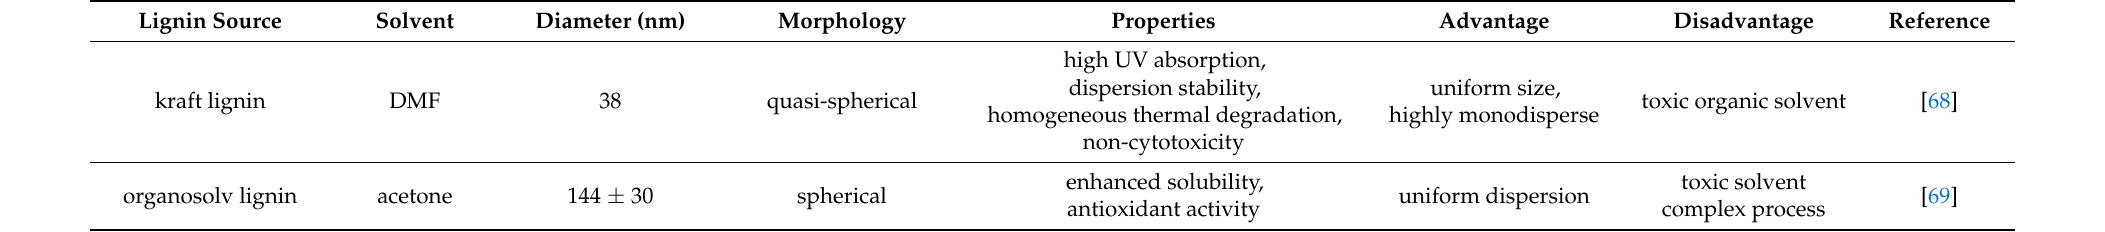
Table 3. Preparation of Lignin Nanoparticles by Using Supercritical CO 2 as Anti-solvent.